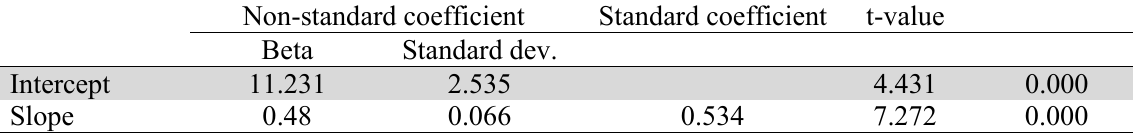
The summary of regression test between EI and